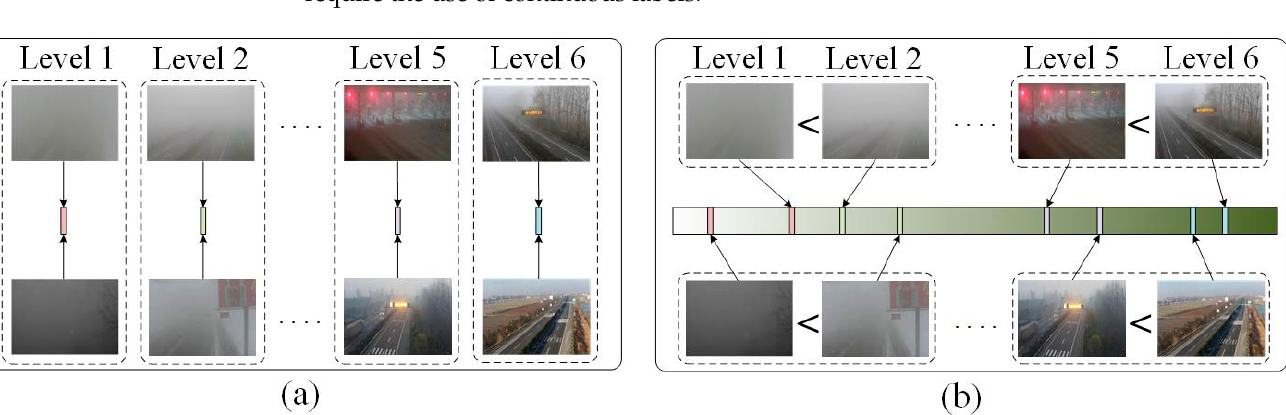
Figure 1. Demonstration diagram of the ordinary classification ( a ) and the proposed ordinal relative estimation ( b ). The green axis shows the visibility, which increases from left to right. In ( a ), foggy images are inducted into corresponding levels. In ( b ), the method compares the strength of visibility in paired images and projects on the visibility axis with ordinal constraints.